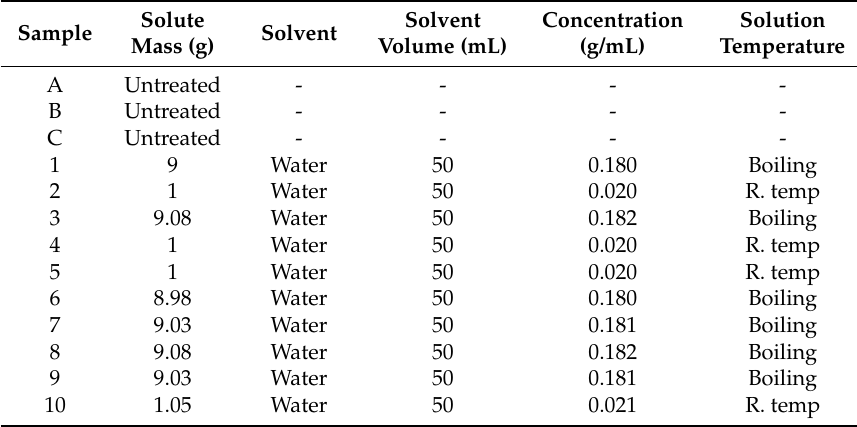
Table 1. Impregnation conditions of the samples.